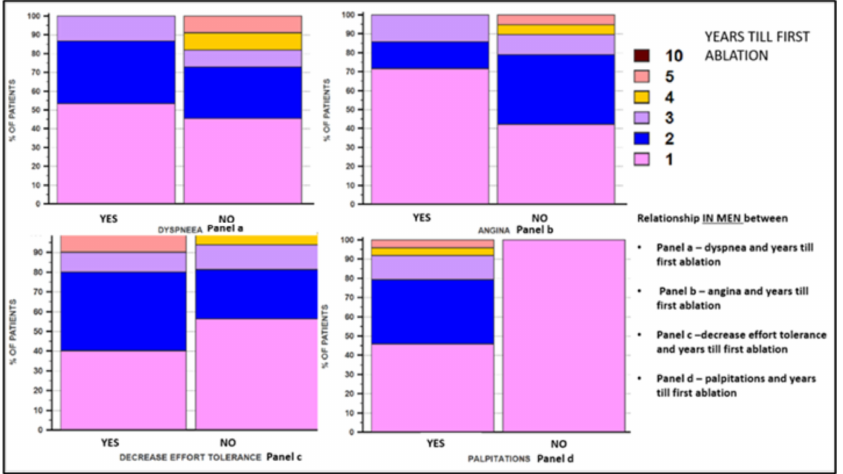
Figure 5. The correlation between the symptoms of male patients and the number of years that passed until the ablation was